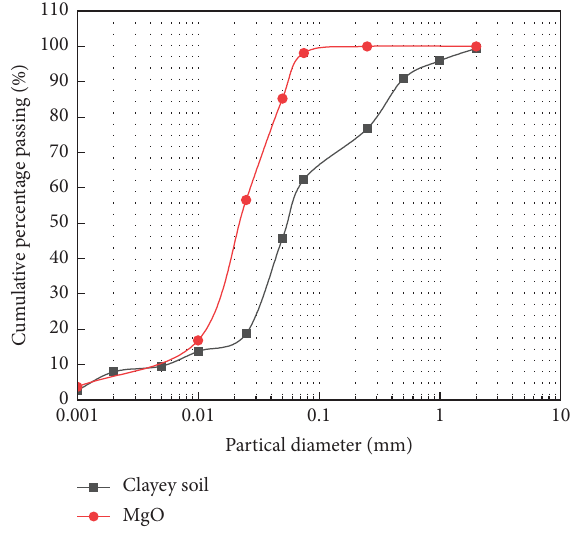
Figure 1: Particle gradation of clayey soil and